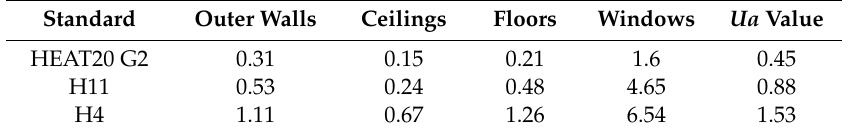
Table 2. Transmission heat transfer coefficients (W/m 2 K) for each part of walls for different standards.